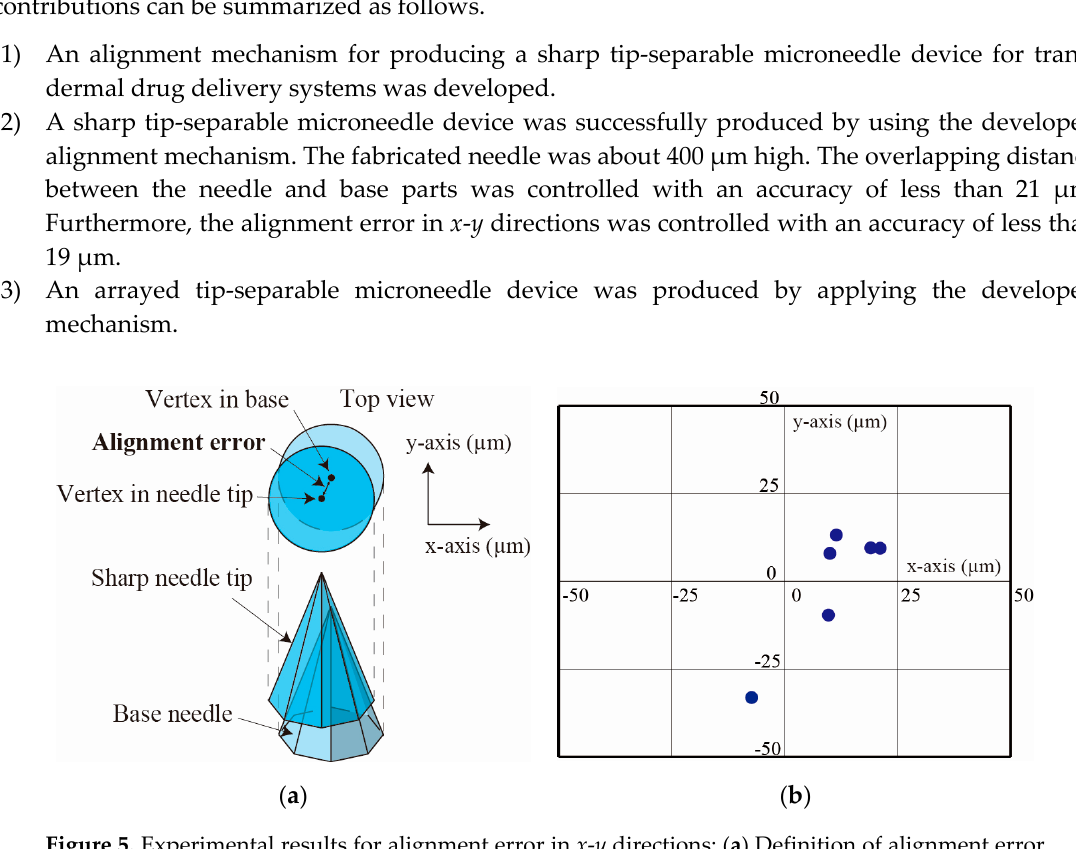
Figure 5. Experimental results for alignment error in x - y directions: ( a ) Definition of alignment error in x - y directions; ( b ) Experimental results for alignment